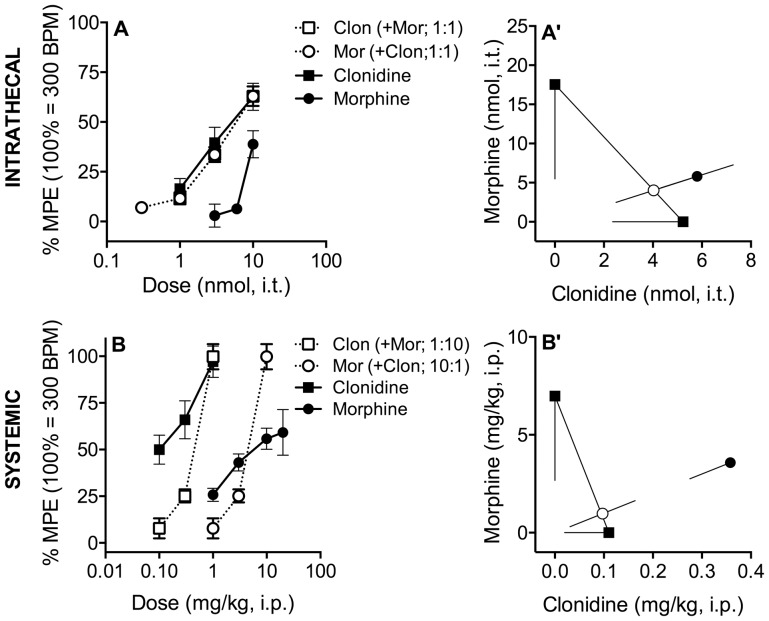
Effects of Morphine and Clonidine on Heart Rate.
A. Heart rate was challenged by intrathecal morphine, clonidine or both. Morphine (•) and clonidine (▪) inhibited heart rate in a dose-dependent manner. When the agonists were co-administered at a constant ratio of 1∶1 (○ morphine; □ clonidine), no increases in potency or efficacy were observed. A′. Isobolographic analysis applied to the data from Figure 3A. The y-intercept represents the ED50 for morphine and the x-intercept represents the ED50 for clonidine. The lines directed from each ED50 value toward zero represent the respective lower 95% confidence limits of each ED50. The line connecting these two points is the theoretical additive line. The unfilled circle on the theoretical additive line represents the calculated theoretical ED50 value of the combination if the interaction is additive. The observed combination ED50 (•) is not significantly (p<0.05; t-test) different from the theoretical additive ED50 (○), indicating that the interaction is additive. B. Systemically administered morphine (•) and clonidine (▪) dose-dependently inhibited heart rate when administered alone or in combination at a constant morphine∶clonidine dose ratio of 10∶1 (○ morphine; □ clonidine). B′. Isobolographic analysis applied to the data from Figure 3B. The observed combination ED50 (•) is significantly (p<0.05; t-test) higher than the theoretical additive ED50 (○), indicating that the interaction is sub-additive. Data pictured were obtained 10 minutes following intrathecal (Figures 3A, A′) and 15 minutes following systemic administration (Figures 3B, B′). Error bars represent ±SEM for each dose point (n = 6–10 animals/dose). See Table 1 for ED50 values. Note: 100% MPE was artificially set at 300 beats per minute (baseline ∼800) to facilitate dose-response and isobolographic analysis.